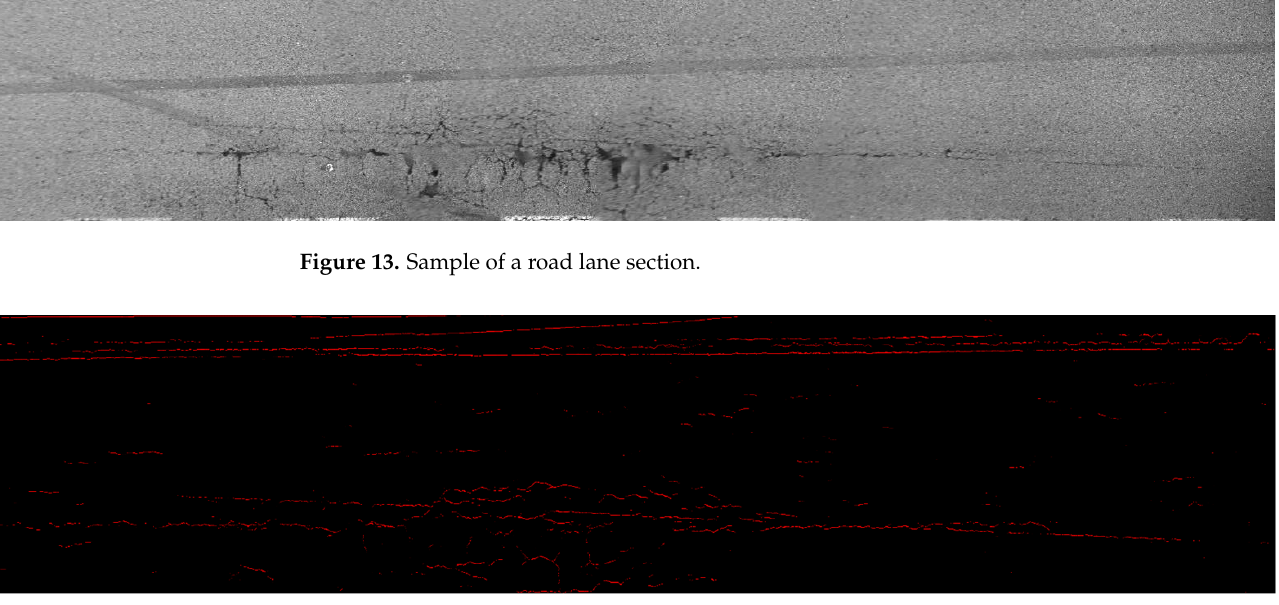
Figure 14. Road lane section segmented by the segmentation neural network.